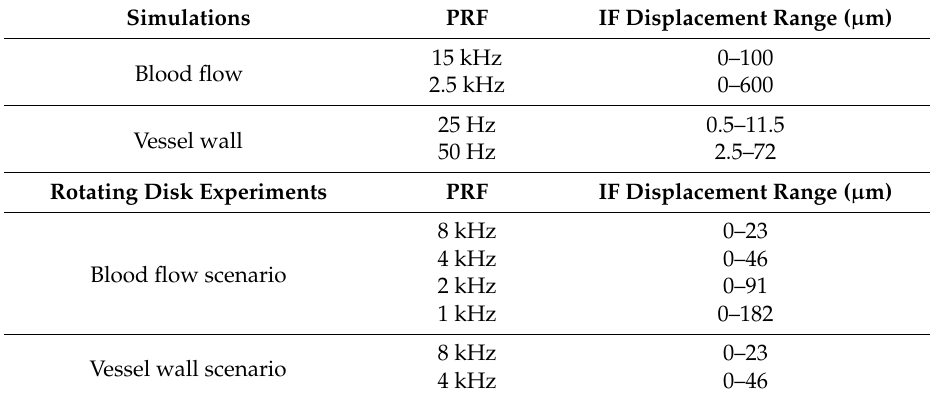
Table 2. Imaging pulse repetition frequency (PRF) and resulting inter-frame (IF)